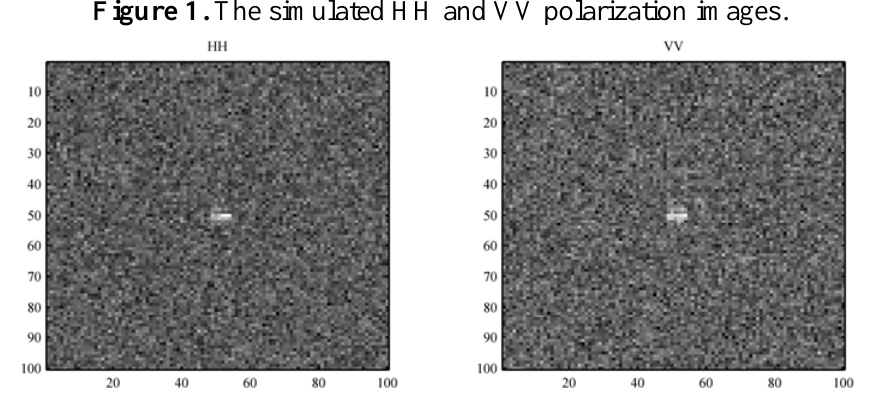
Figure 1. The simulated HH and VV polarization